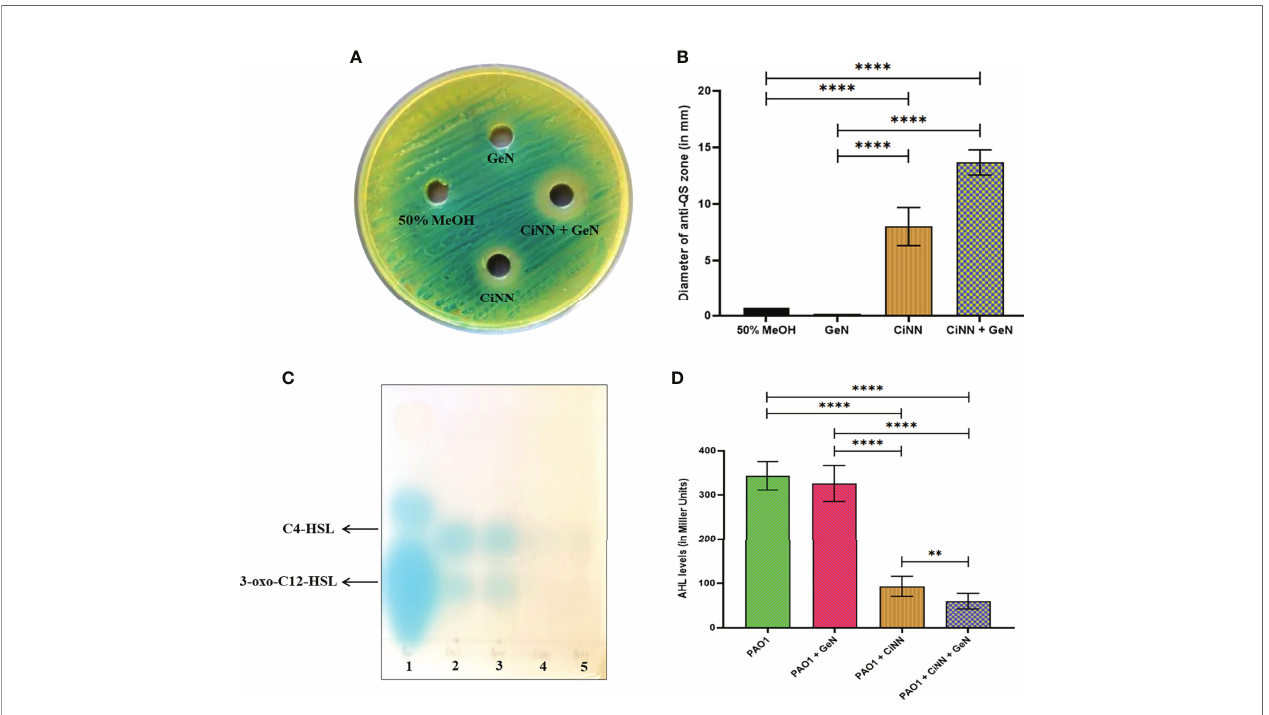
FIGURE 3 | Analyzing the anti-QS activity of CiNN and GeN, alone and in combination. (A) Qualitative test showing the colorless zones surrounding the wells indicating the quorum quenching potential of CiNN employing Agrobacterium tumefaciens NTL4 biosensor strain. (B) Graph showing the diameter of anti-QS zones obtained with the test agents. (C) TLC agar overlay technique with AHLs. Lane 1: AHL standard containing C4-HSL, C8-HSL, and 3-oxo-C12-HSL, Lane 2: AHLs extracted from untreated PAO1 (Control), Lane 3: AHLs extracted from GeN-treated culture, Lane 4: AHLs extracted from CiNN-treated culture, Lane 5: AHLs extracted from CiNN-GeN-treated culture. (D) b -galactosidase assay for the quanti fi cation of AHL production in treated and untreated PAO1 cultures. (**p ≤ 0.01, ****p ≤